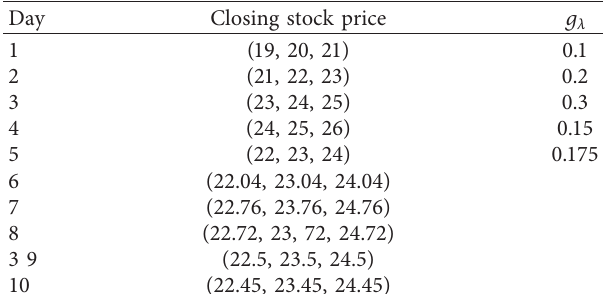
Table 2: Closing stock prices over 10